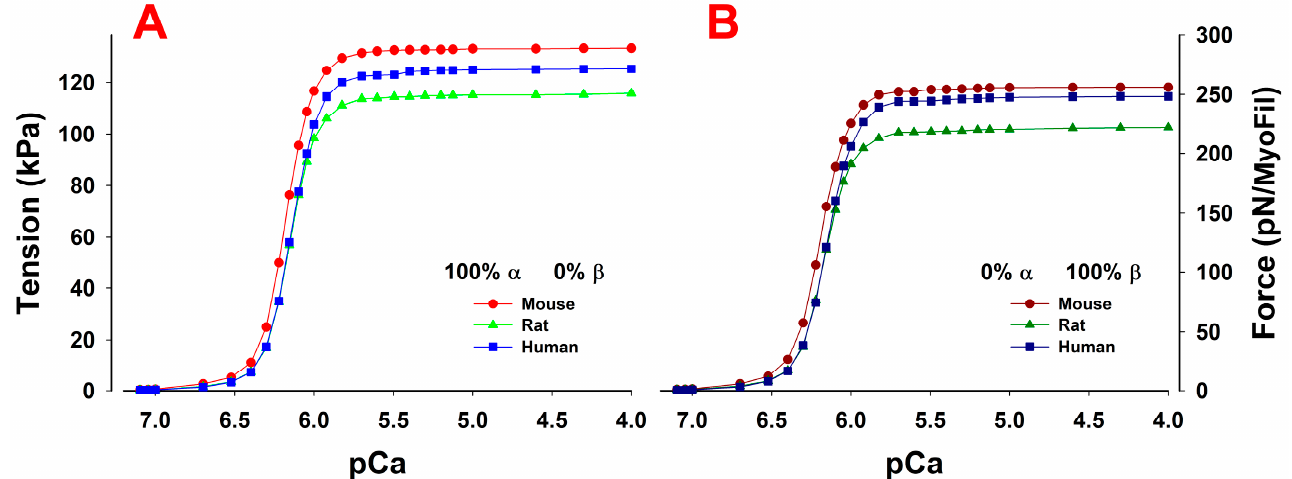
Figure 6. Force-pCa relations of trabeculae containing ( A ) 100% α - or ( B ) 100% β -isoforms in mouse, rat and human cardiac muscles. At full activation at pCa < 5.5, all cases showed similar tension with differences between the species of <20 kPA or <20% of the largest tension, and even less between the corresponding α and β in the same species. For the α - and β -isoforms, the mouse showed the highest and the rat the lowest tension. Interestingly, all showed very similar Hill coefficient n H and pCa 50 values. Table 3. Isometric tension (kPa) at [Ca 2+ ] = 10 µM.